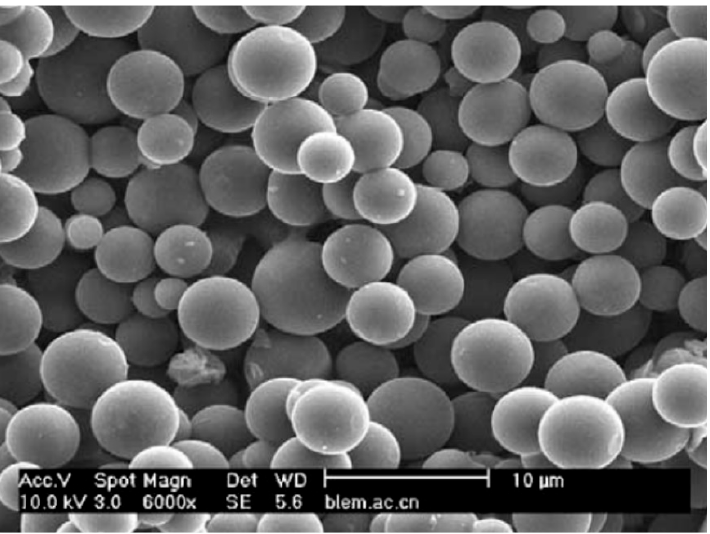
Figure 4. SEM image of hard carbon spherules. Reprinted from [80] with permission from Elsevier.